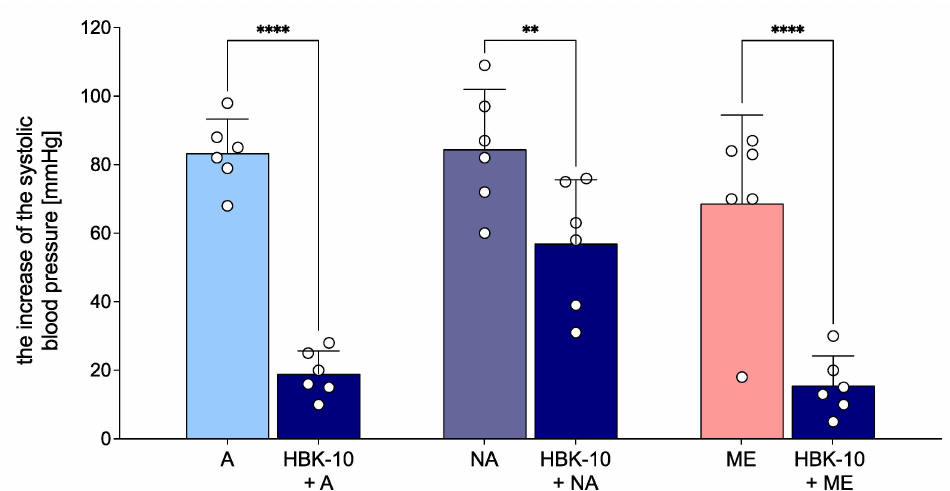
Figure 3. The effect of HBK-10 on adrenaline-, noradrenaline-, and methoxamine-induced pressor response. Pressor response to adrenaline (2 µ g/kg), noradrenaline (2 µ g/kg) and methoxamine (150 µ g/kg) was estimated before and 5 min after the intravenous ( iv ) administration of HBK-10 at the dose of 1.25 mg/kg. The results are presented as means ± SD, circles represent individual data points. Statistical analysis: one-way repeated measures ANOVA (Bonferroni post hoc); ** p < 0.01, **** p < 0.0001; n = 6 rats. A—adrenaline, NA—noradrenaline,